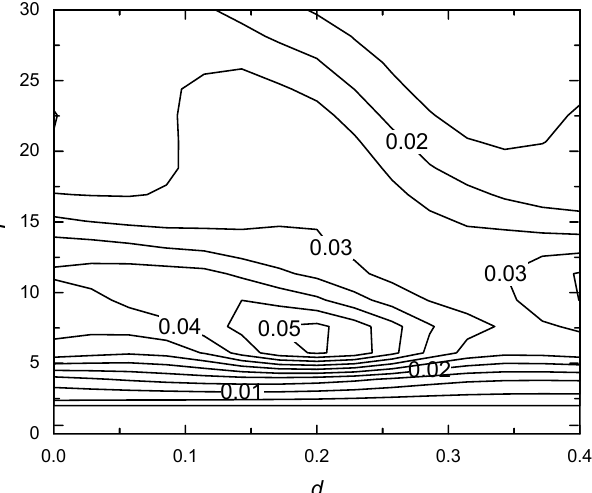
Fig.5. Contour plot of the likelihood L for the determination of the best combination of the parameters ( P , d ) , tested for different model distributions. The plots are normalized so that the sum of the likelihoods of all models is equal to 1. The best combination is found at P = 6 and d = 0 .